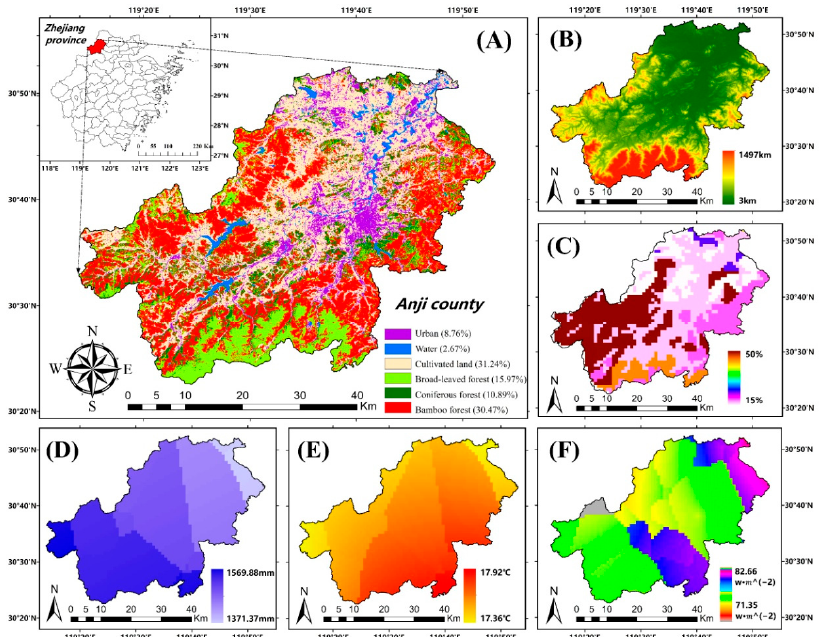
Figure 1. Location and natural environment of the study area: ( A ) land-use types in 2014, ( B ) elevation in 2014, ( C ) soil clay fraction in 2008, ( D ) total precipitation in 2014, ( E ) average temperature in 2014, and ( F ) average radiation in 2014.